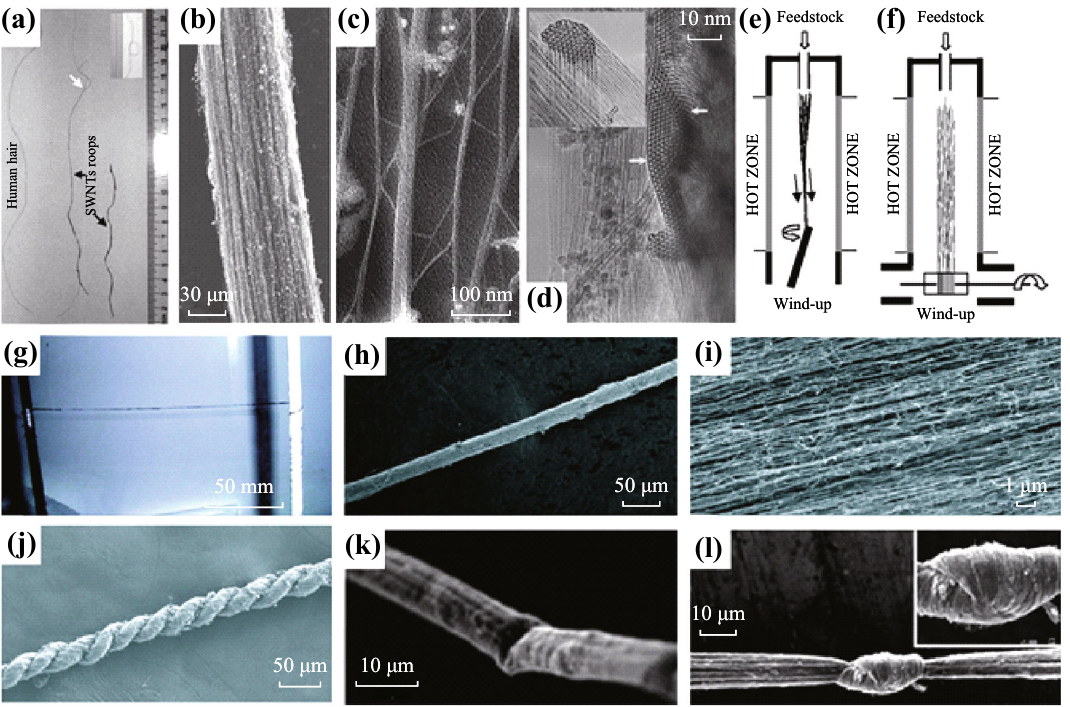
Fig. 6 a Optical image showing a human hair and two as-grown SWNT fibers. SEM images of CF at low b and high c magnification. d HRTEM image of a top view of a SWNT fiber. Schematic of the direct spinning process with the spindle aligned at 25 (cid:3) ( e ) and normal to f the furnace axis. g Photograph of CFs wound from the spindle (left) onto a second spindle (right). SEM images of CF at low ( h ) and high i magnification. j A twisted CF after its removal from the furnace. SEM image of CFs showing a kink induced by bending ( k ) and showing an overhand knot ( l ). a – d Reproduced with permission from Ref. [27]. Copyright 2002, American Association for the Advancement of Science. e – j Reproduced with permission from Ref. [28]. Copyright 2004, American Association for the Advancement of Science. k , l Reproduced with permission from Ref. [29]. Copyright 2010,